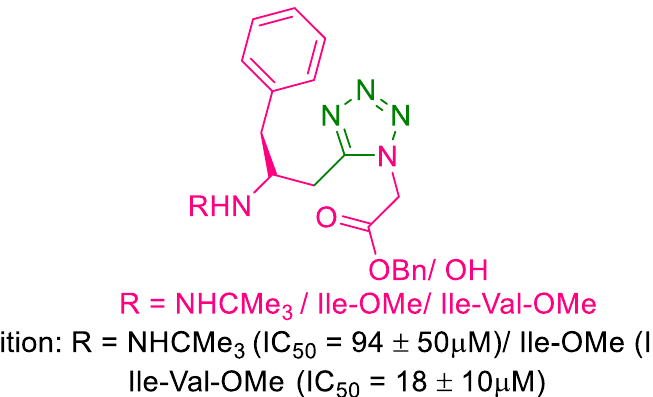
Figure 14. Tetrazole-based peptidomimetics.